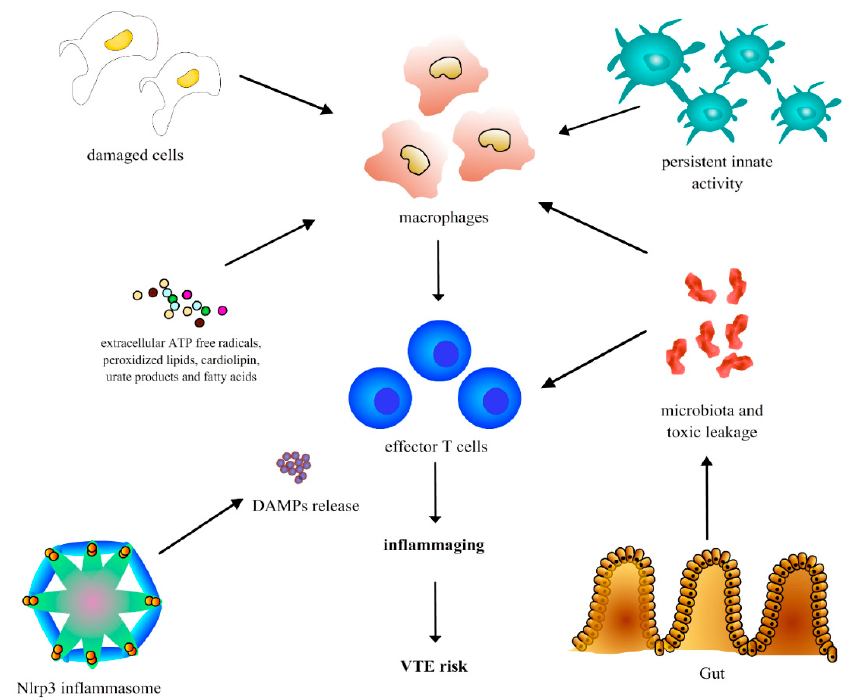
Figure 1. The main molecular mechanisms that could lead to chronic inflammation in the elderly and risk of